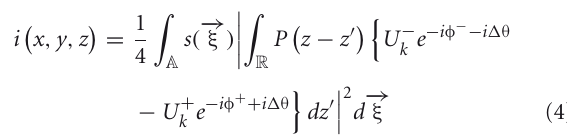
THE DIC IMAGE CONTRAST ARISES FROM SUB-CELLULAR DENSITY GRADIENTS ALONG THE SHEAR DIRECTION OF THE WOLLASTON